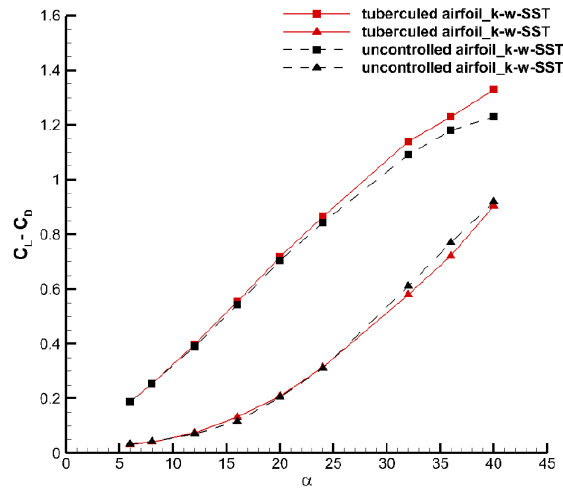
Fig. 4. Aerodynamic for coefficients for the k- ω SST turbulence